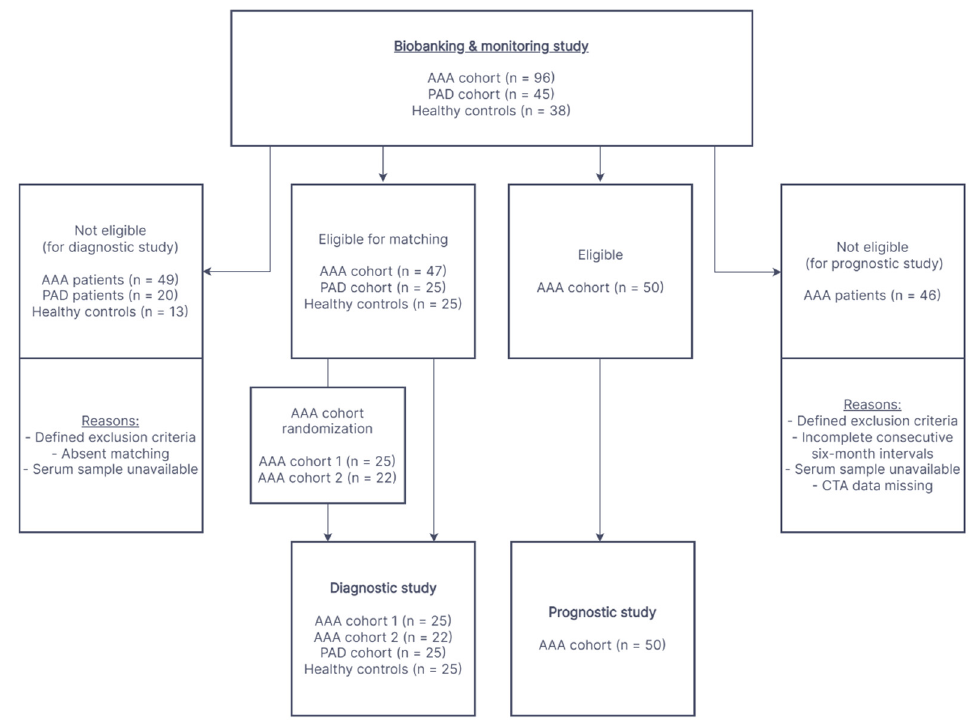
Figure 4. Enrollment flow chart. This flow diagram shows the progress through the phases of par- ticipant recruitment for the diagnostic and prognostic study. The cohorts of both study settings were recruited from a biobanking and monitoring study. Abbreviations: AAA, abdominal aortic aneu- rysm; PAD, peripheral artery disease; CTA, computed tomography